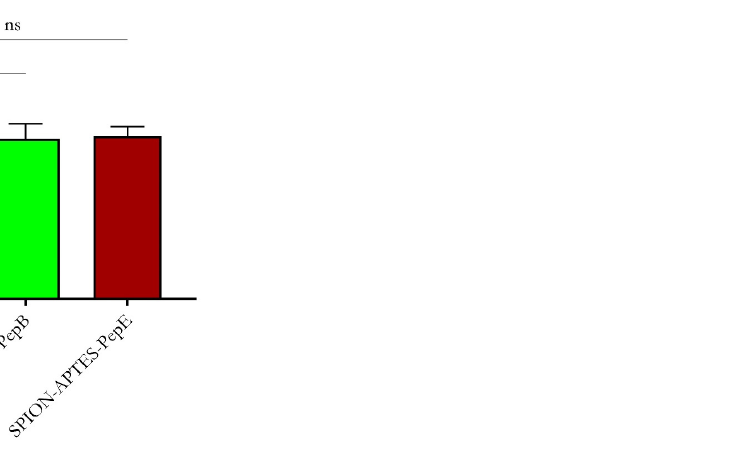
Figure 3. The amount of different peptides bound to SPION-APTES as determined by measurement of supernatants at 280 nm after the functionalization procedure. The results shown represent the mean values with standard deviations of three independent experiments. Statistical testing was per- formed using a Kruskal – Wallis test. p values above 0.05 were considered non-significant (ns). The physicochemical characteristics of SPION-APTES functionalized with various peptides did not show significant differences, as depicted in Figure 4. The hydrodynamic size (z-average) of the particles was found to be around 1.7 µm with a polydispersity index (PDI) of approx. 0.2–0.3 (Figure 4A,B). It should be considered that the dynamic light scat- tering DLS measurements show the hydrodynamic size of aggregates formed by small cores of about 12 nm (see also Appendix Figure A1), as also shown in a previous publica- tion [18]. Further, this study also showed that superparamagnetic behavior was still visi- ble after the functionalization with peptide, as seen in the VSM measurements. The ζ -potential was found to be 29 mV for all functionalized particles (Figure 4C). All particles exhibited a good visible magnetic removability from media, which is a pre- requisite for the capture of bacteria. As reported before in previous studies, the particles proved to have good bio- and hemocompatibility, making them usable for separation un- der physiological conditions [18].